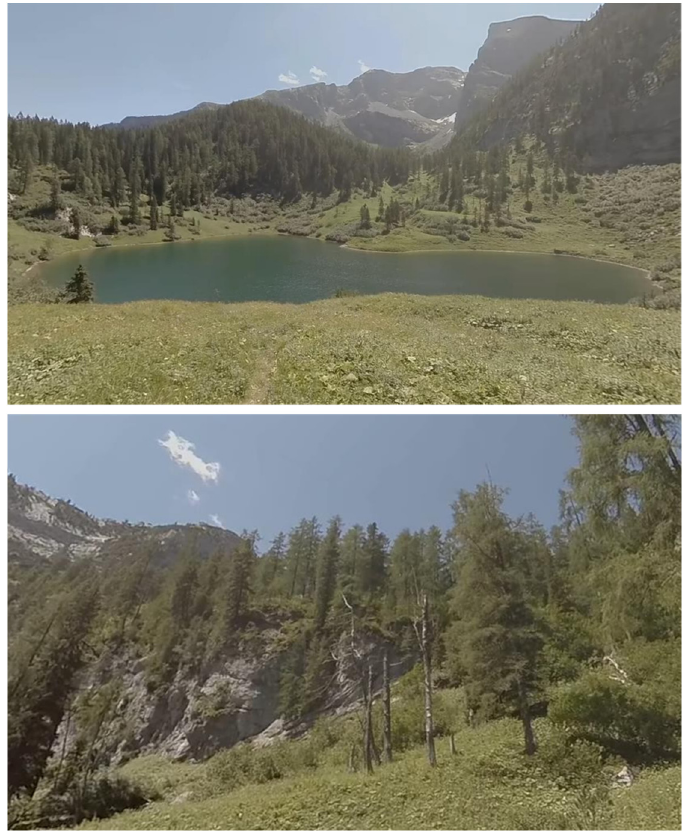
Figure 3. VR-nature exposure, front and back perspectives.